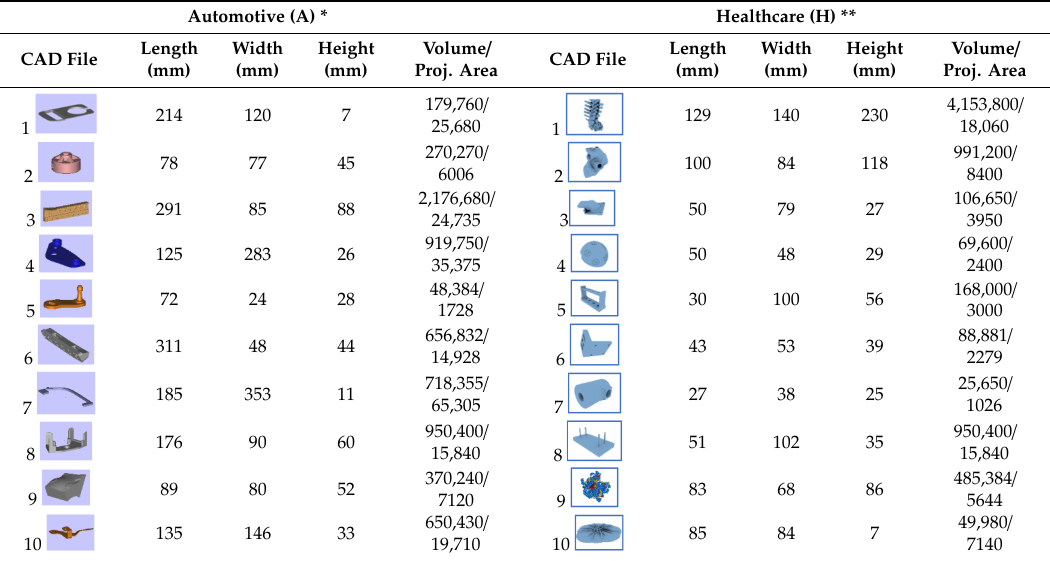
Table 3. Case study parts.